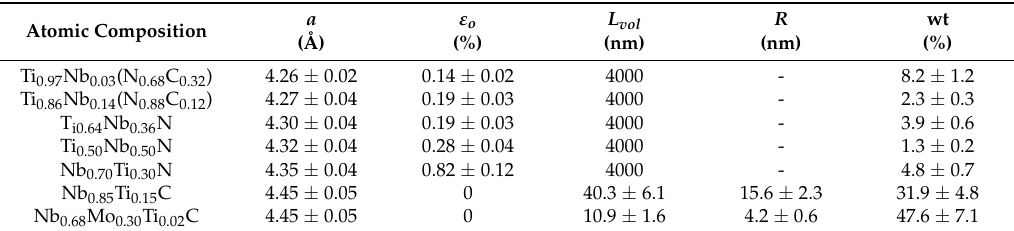
Table 4. Refinement results for X70 steel.